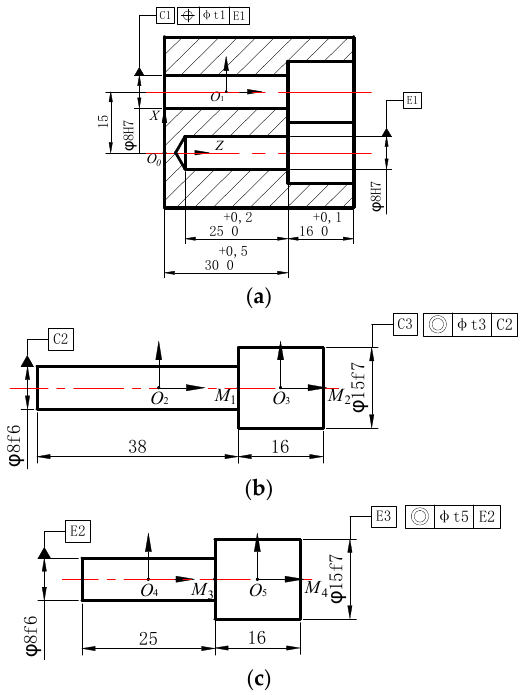
Figure 5. Gear pump (Unit:mm): ( a ) Pump body; ( b ) Leading shaft and gear; ( c ) Shaft and gear.